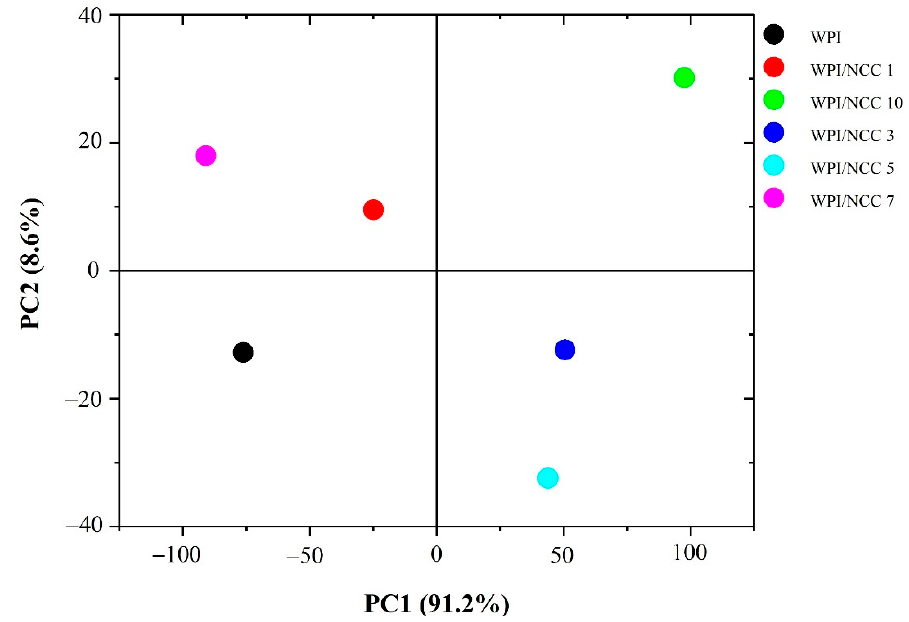
Figure 5. Scatterplot based on principal component analysis (PCA) of FTIR spectra of film.